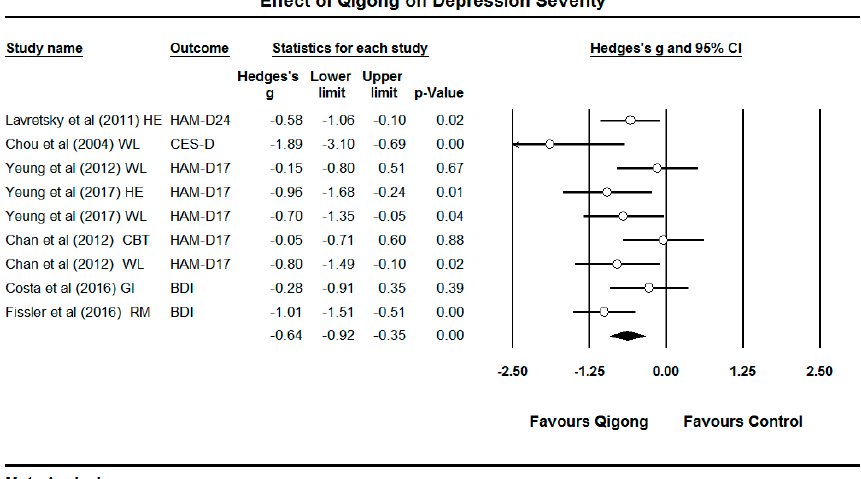
Figure 2. Effects of Qigong on depression severity. Note: HAM-D24 = 24-item Hamilton Depression Rating Scale, HAM-D17 = 17-item Hamilton Depression Rating Scale, CES-D = Epidemiological Studies Depression Scale, BDI = Beck Depression Inventory. HE = heath education, WL = waitlist, CBT = cognitive behavioral therapy, GI = guided imagery, RM = rest and music.